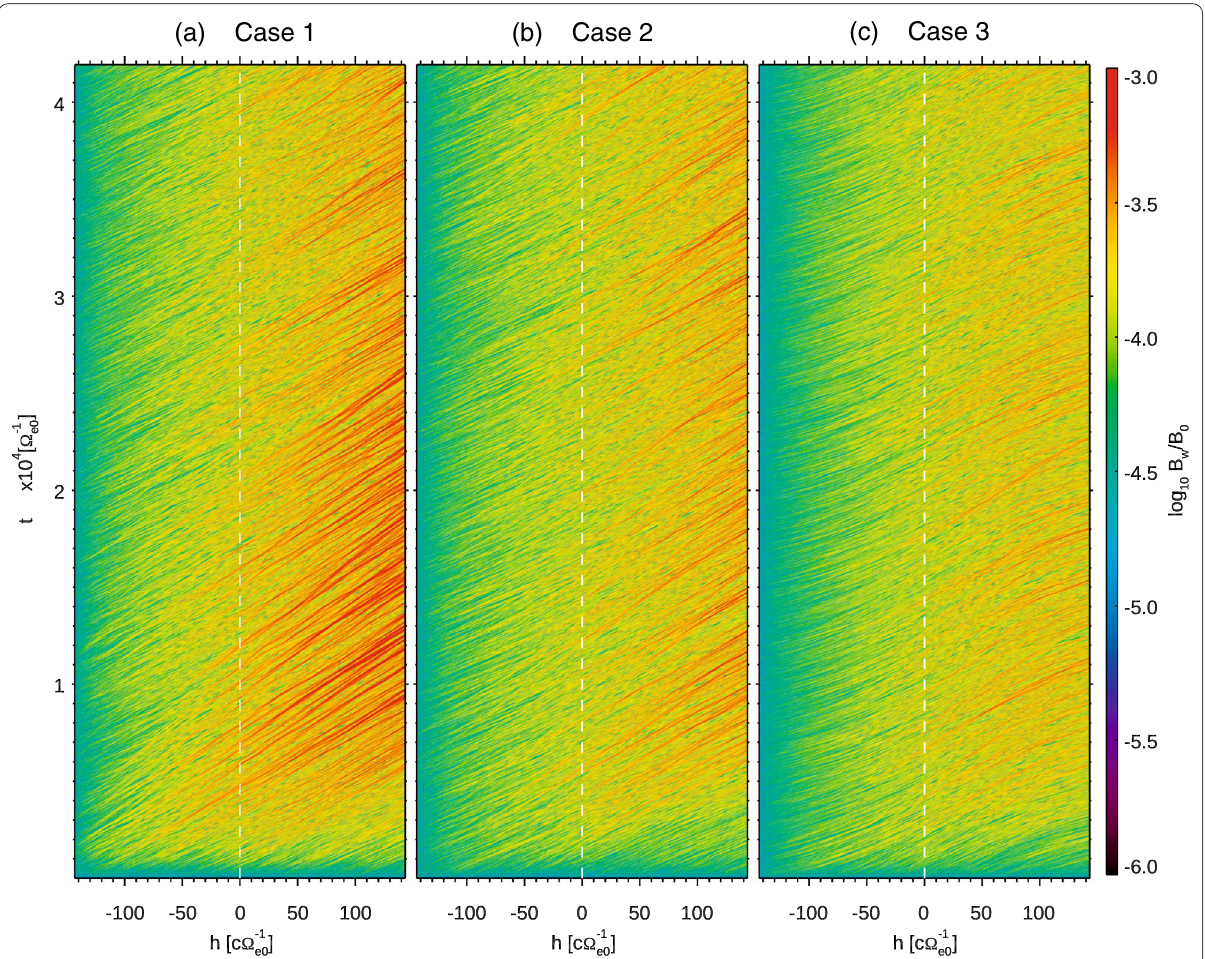
Fig. 3 Spatial and temporal evolution ( t = 0 ∼ 4.2 × 10 4 [ (cid:31) − 1 e 0 ] ) of amplitudes of forward-propagating waves in a Case 1 ( a = 1.87 × 10 − 7 (� e 0 / c ) 2 ); b Case 2 ( a = 3.74 × 10 − 6 (� e 0 / c ) 2 ), and c Case 3 ( a = 3.74 × 10 − 5 (� e 0 / c ) 2 ), respectively. The dashed white lines indicate the magnetic